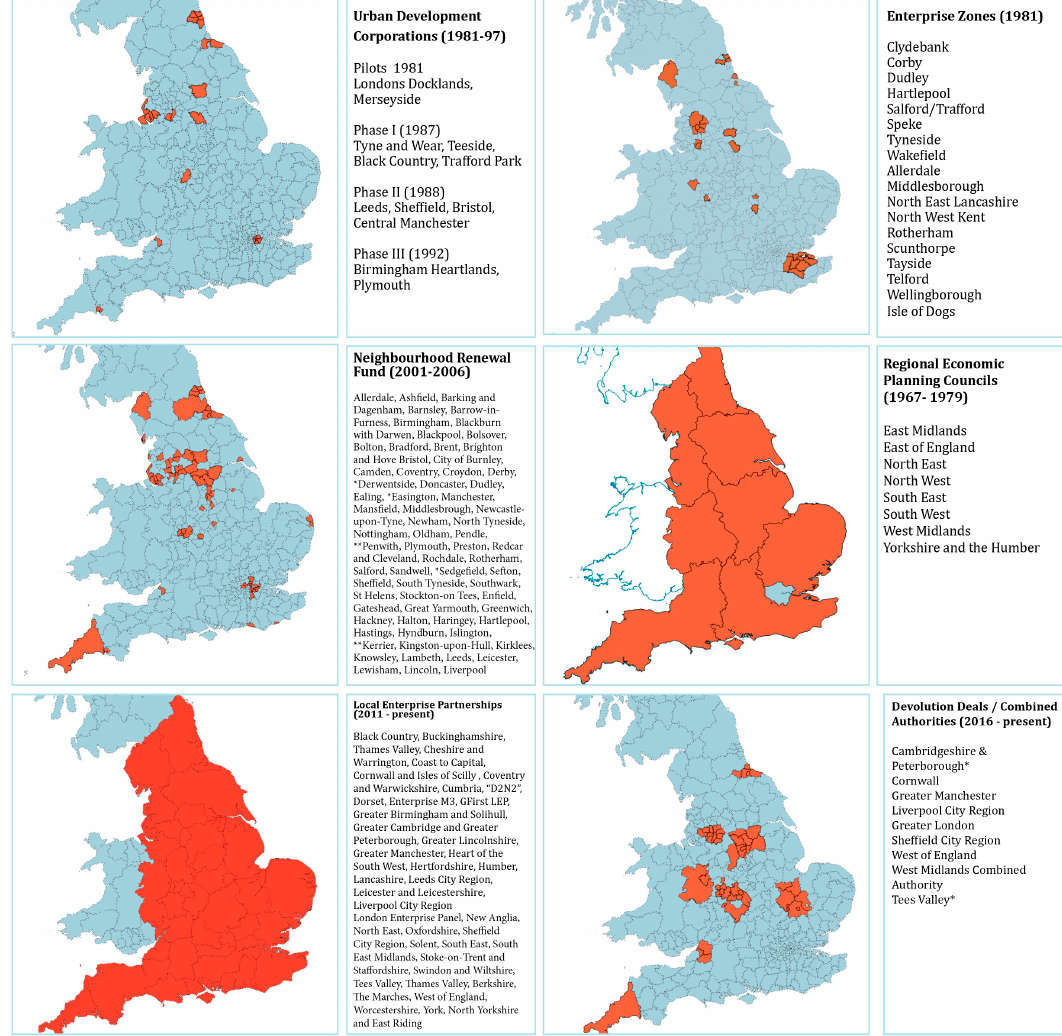
Figure 1. Select maps of post-war area-based initiatives in England.